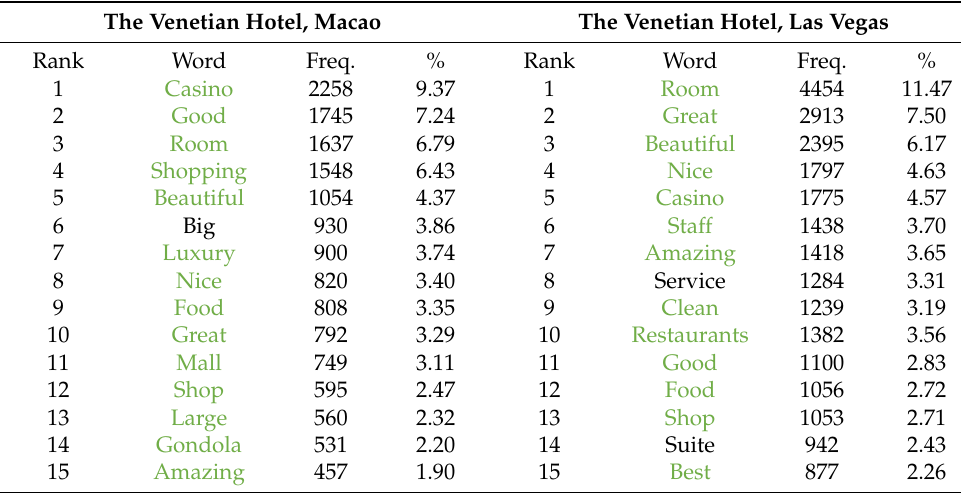
Table 1. Top keywords’ frequency of the case hotels.